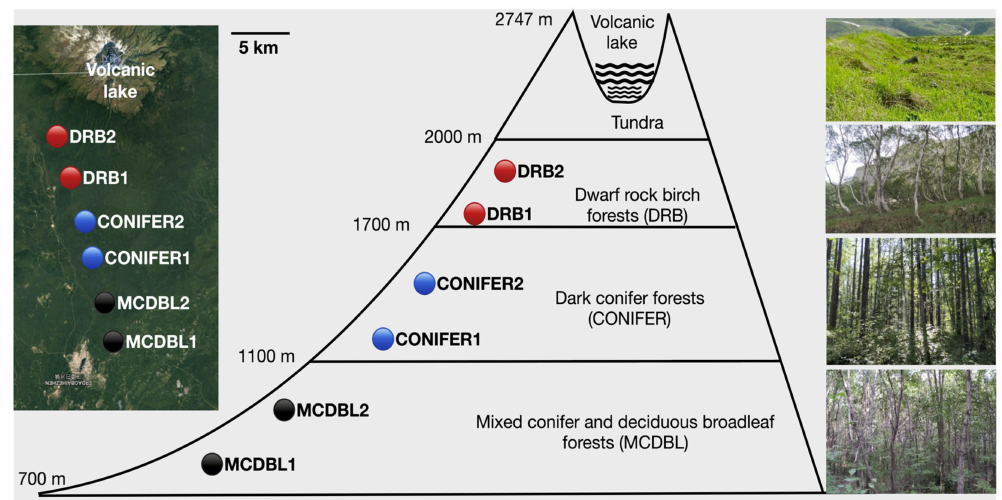
Figure 1. Diagram map of sampling sites from three forest types along elevations on the northern slope of Changbai Mountain in Northeast